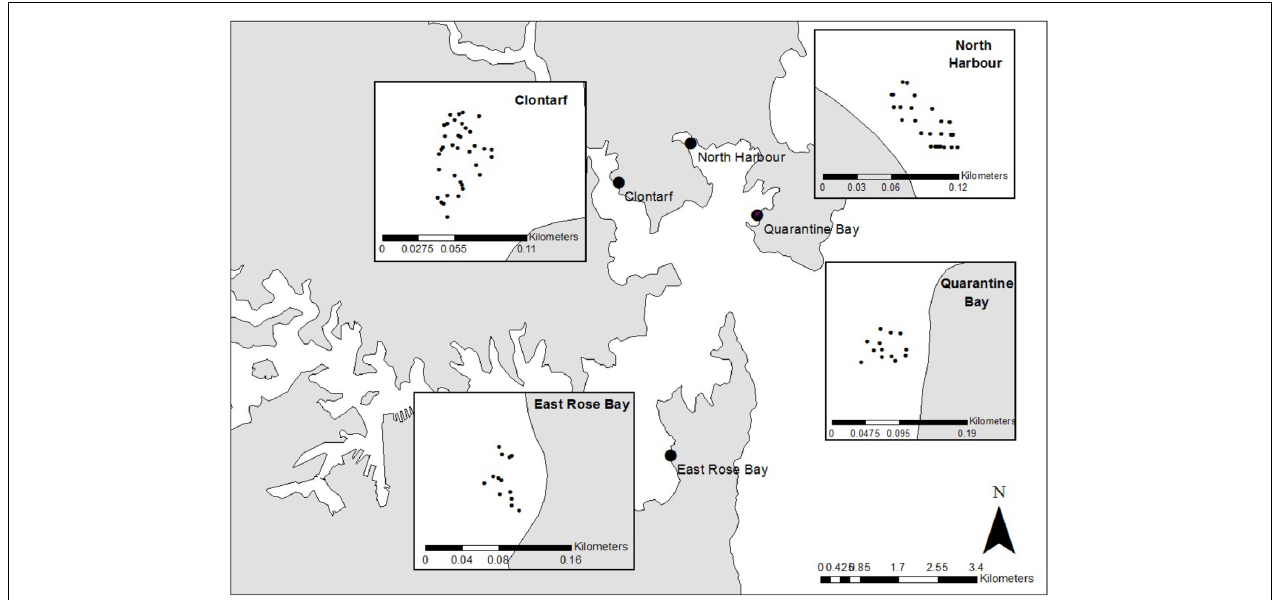
FIGURE 1 | The location of sampling locations, and sites within locations, in Sydney Harbour, Australia. Moorings were present at Clontarf ( n = 36 samples taken) and North Harbour ( n = 28). The reference locations lacking moorings were East Rose Bay ( n = 13) and Quarantine Bay ( n = 13).